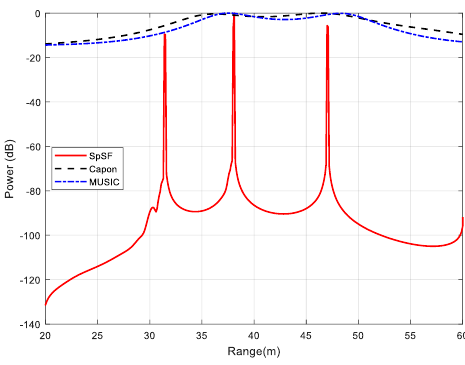
Figure 12. Range estimation of the real data.